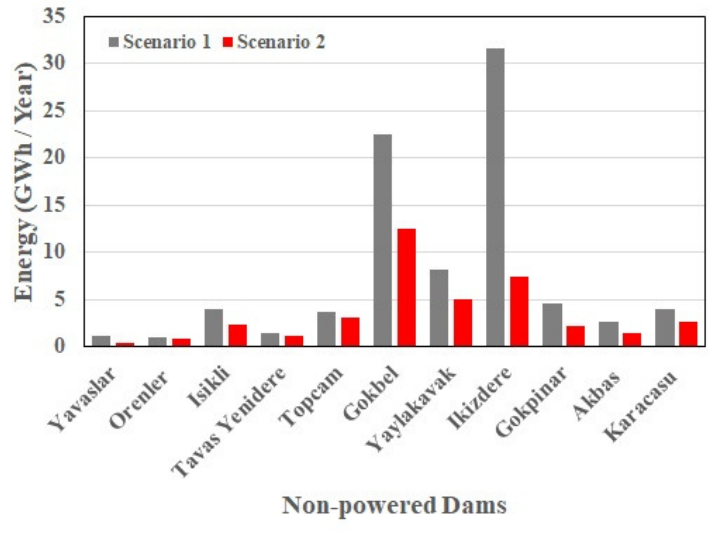
Figure 4. Comparison of the annual average energy production of 11